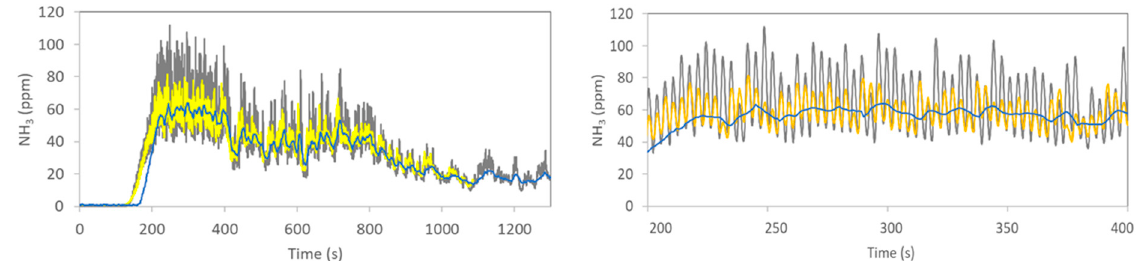
Figure 8. NH 3 emission profiles measured during an idle test using the OBS-ONE-XL (grey), the MEXA-ONE-QL-NX (yellow) and the SESAM (blue) at the VELA7 facilities.